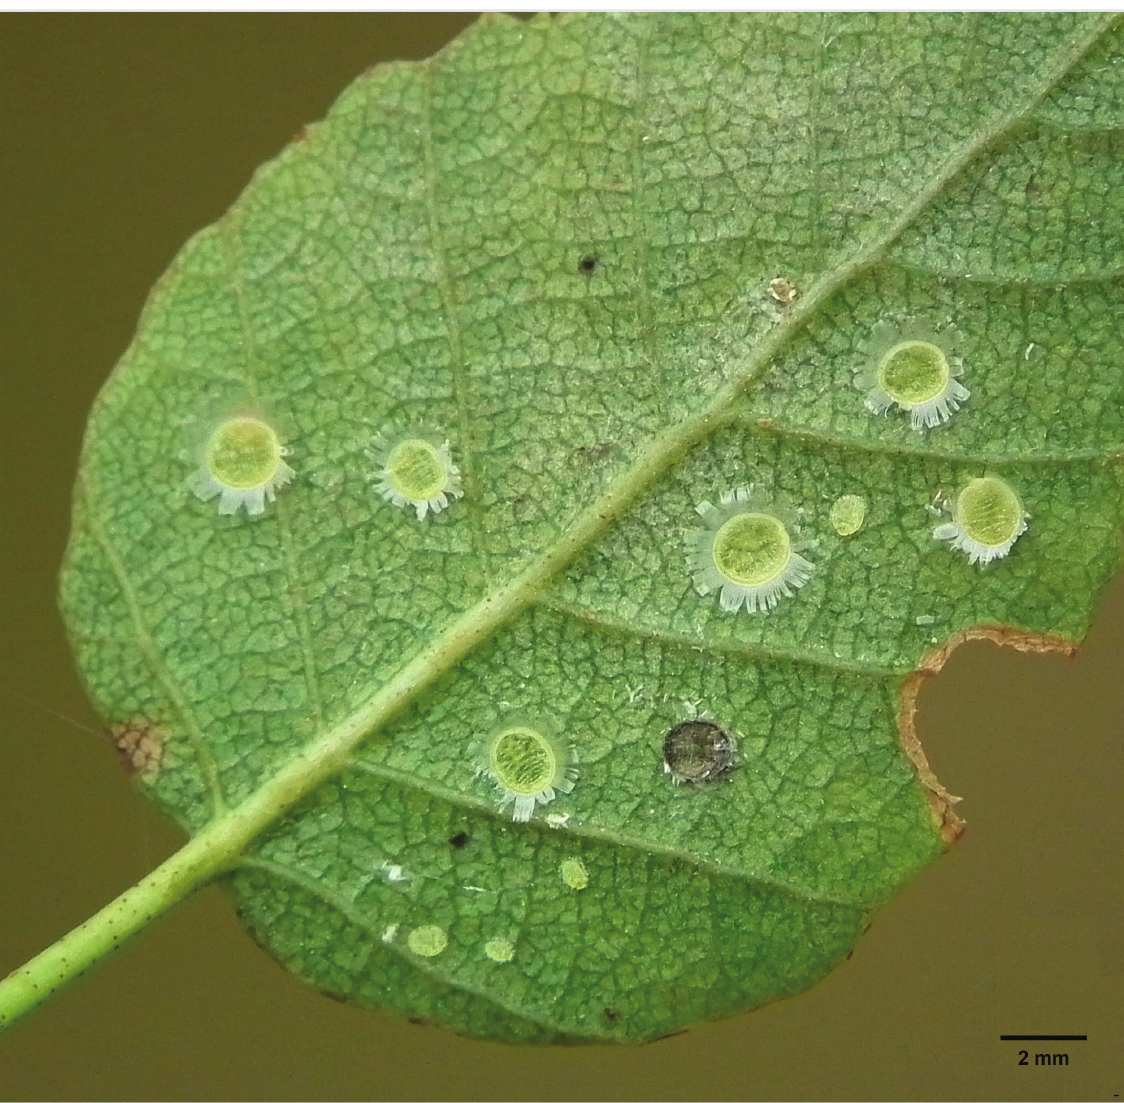
Fig. 15. Hormaphis betulae (Mordvilko, 1901). Apt. (ad. and juv.) on Betula pubescens